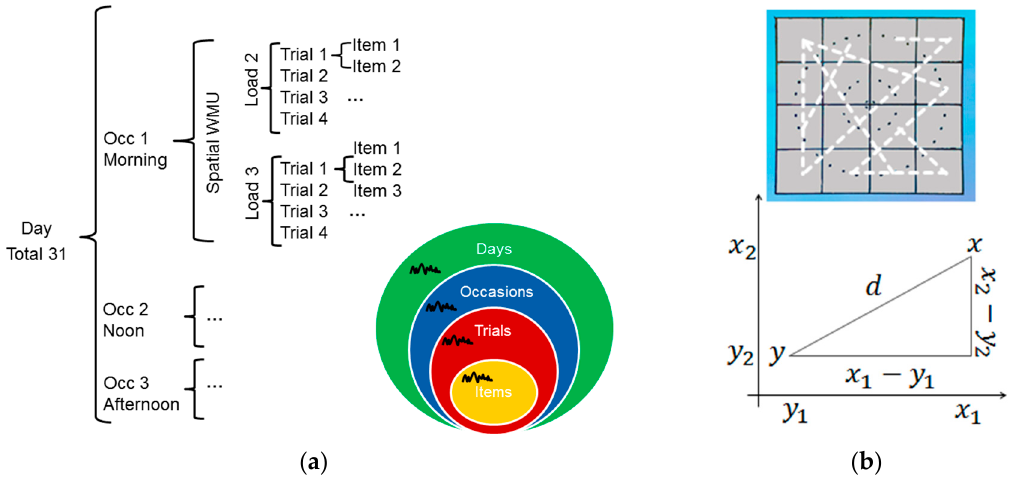
Figure 2. Hierarchical data structure and spatial precision: ( a ) Data were inherently structured by repeated measures at four different levels of time scale (i.e., Items, Trials, Occasions and Days) given the microlongitudinal study design; ( b ) Spatial precision was formalized in terms of the Euclidean Distance δ between presented ( y ) and reported location ( x ) within a 4 × 4 space grid (cf. upper panel). Dashed white lines represent possible distances in the space grid ranging from δ = 0 to a maximum of δ = 4.24.